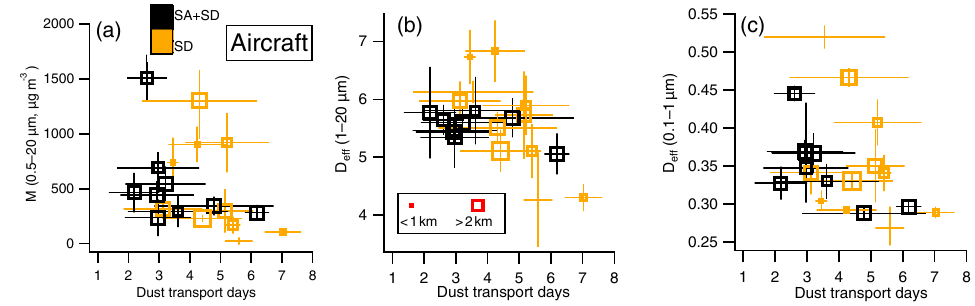
Figure 15. The aerosol mass and effective diameter as a function of dust transport time for all aircraft SLRs.